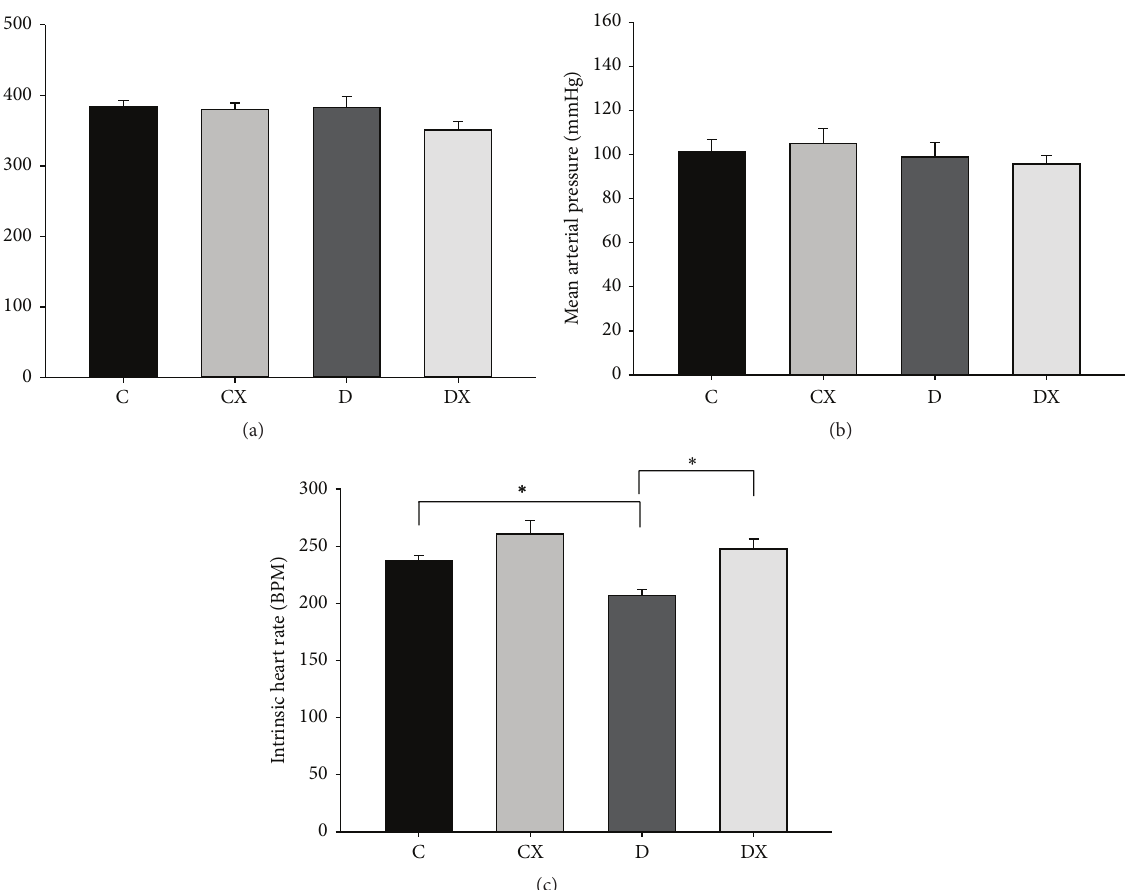
Figure 3: (a) Heart rate (beats per minute) and (b) mean arterial pressure at week 10. C, sedentary control ( 𝑛 = 7 ); CX, control exercise ( 𝑛 = 7 ); D, sedentary T1DM ( 𝑛 = 8 ); DX, T1DM exercise ( 𝑛 = 10 ). (c) Intrinsic heart rate (IHR) at week 10. C ( 𝑛 = 10 ); CX ( 𝑛 = 11 ); D ( 𝑛 = 12 ); DX ( 𝑛 = 9 ). ∗ Significantly different groups ( 𝑝 < 0.05 ). Data are mean ± SE.